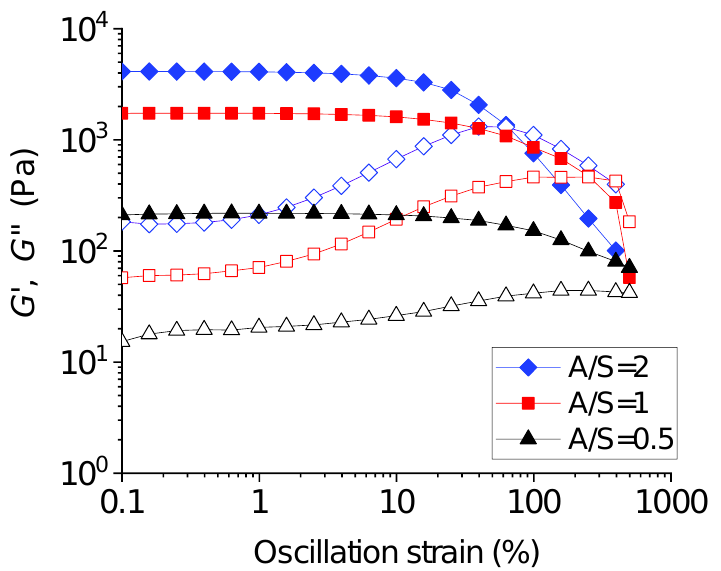
Figure 9. Storage modulus (G′) and loss modulus (G′′) vs. strain of HPMC -g-poly(AM-co-SPA) hydrogels. Data points in the graph: G′—filled symbols; G″— open symbols.